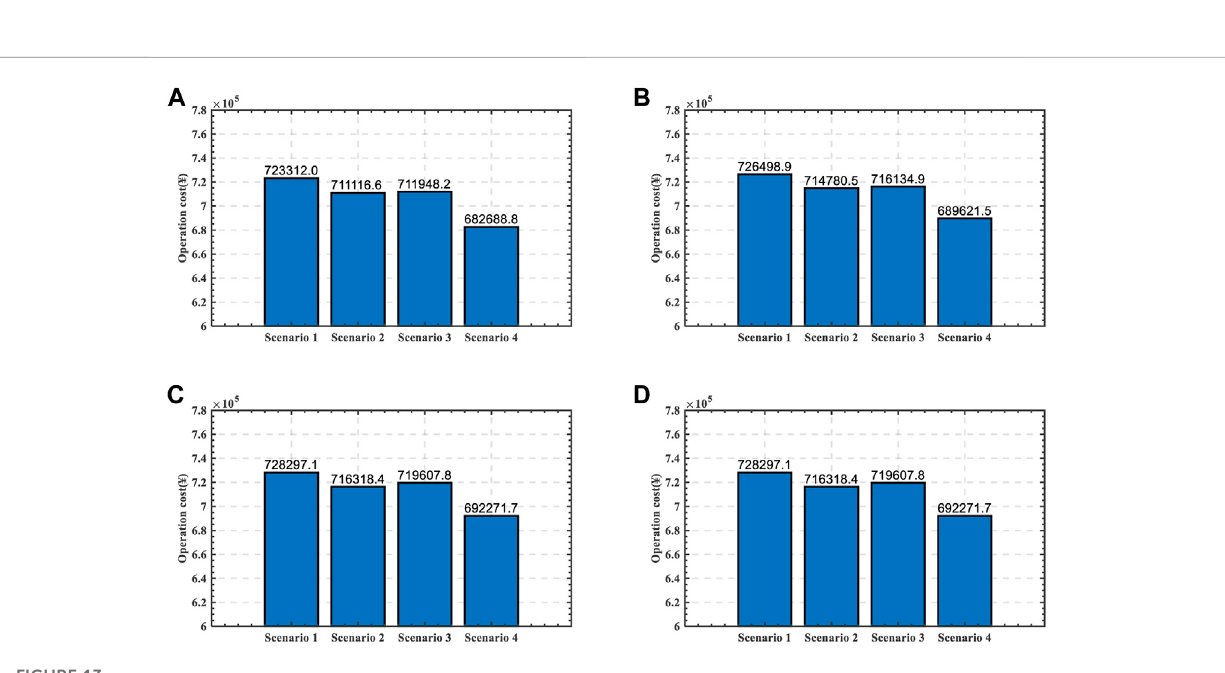
FIGURE 13 The operation cost of DN for the shortest